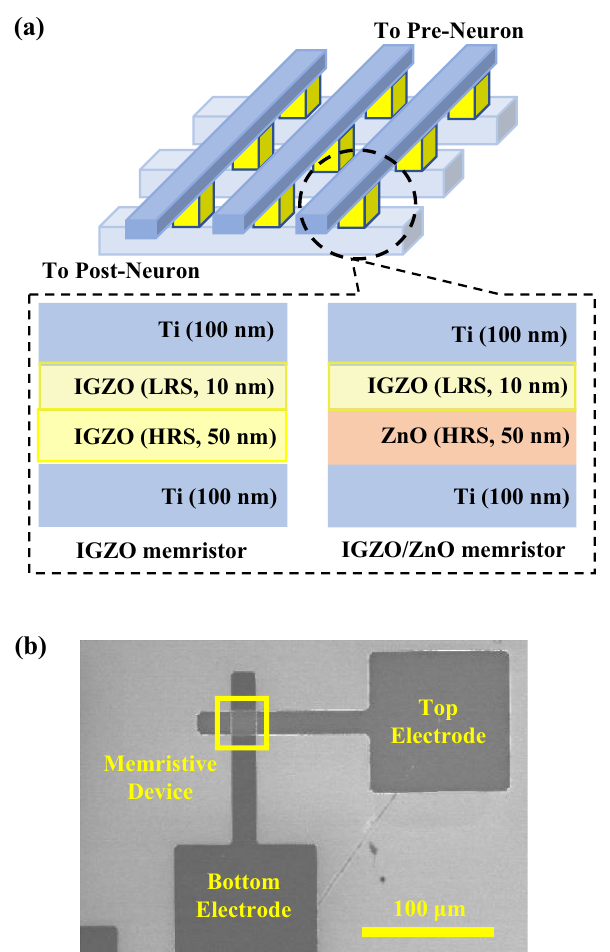
Figure 1. ( a ) A schematic of crossbar structure in a single IGZO and bi-layer IGZO/ZnO memristors (IGZO: Indium-gallium-zinc-oxide, ZnO: Zinc Oxide), ( b ) top-view scanning electron microscopy images of the crossbar structure for the memristor